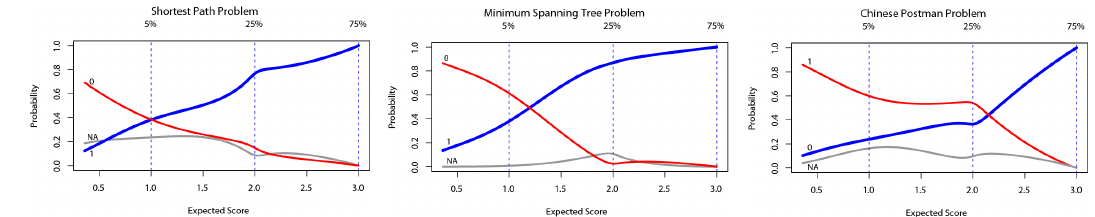
Figure 5. Option characteristics curves describing the relation between the response to the item and the obtained score in binary coding (source: own